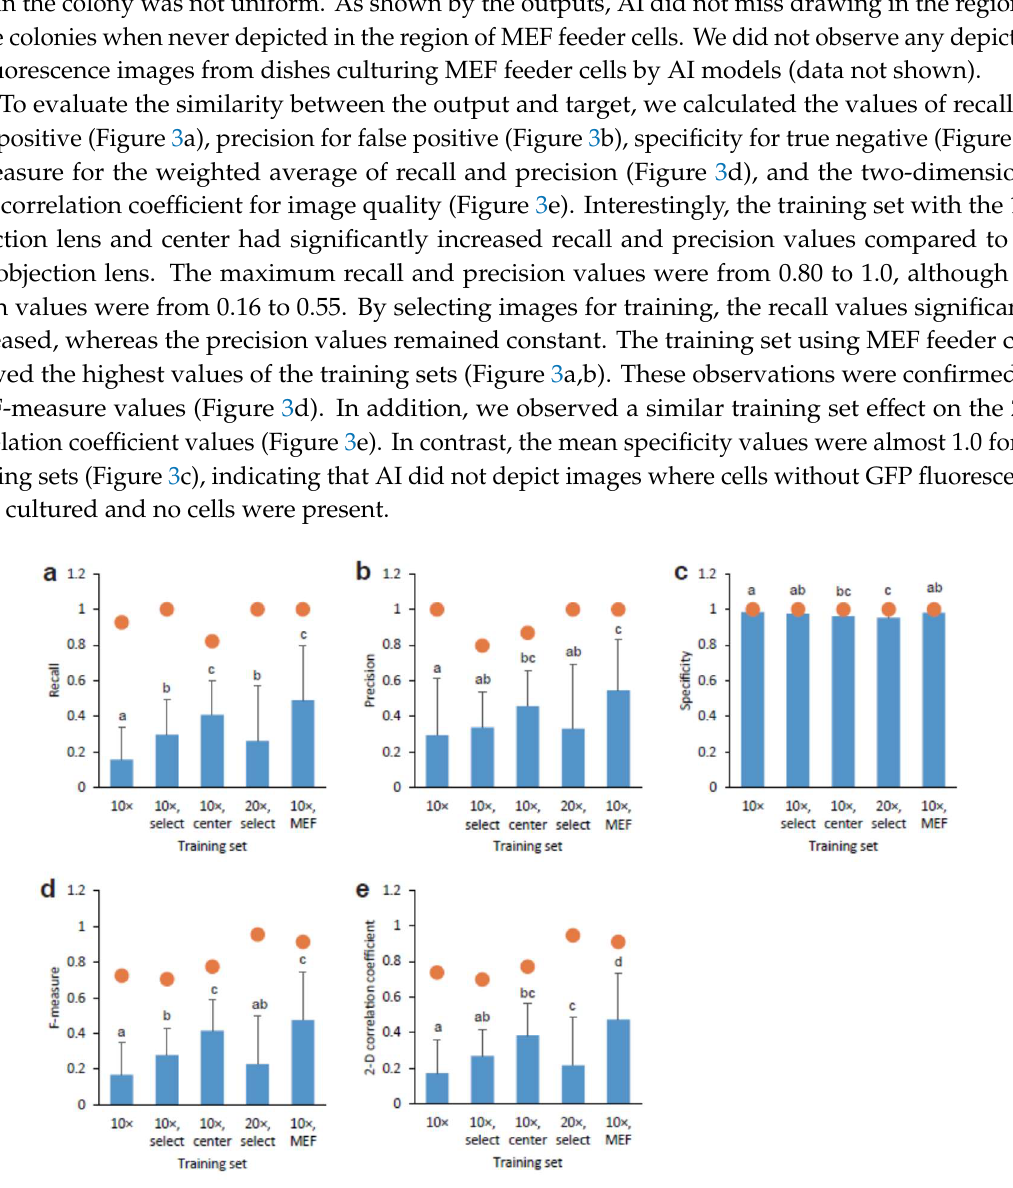
Figure 3. Comparison of depicted CSC images by AI models with original GFP fluorescence. Various AI models obtained from training sets were compared using AI output images and each true target image: ( a ) recall, ( b ) precision, ( c ) specificity, ( d ) F-measure, and ( e ) 2D correlation coefficient. Closed circles indicate maximum values. Mean ± S.D., n = 100 (exception: n = 40 for AI model obtained using training set 10× center). Identical letters labeled up the bars represent no significant difference, p < 0.05, and vice versa.